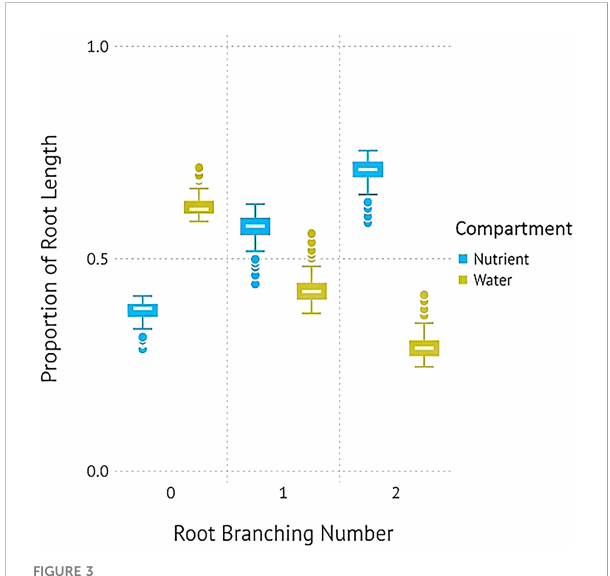
FIGURE 3 Proportions of root length for P. virgatum simulated with the 3D root structure CropRootBox.jl model parameterized for the resource-partitioned treatment in an attempt to replicate Figure 1A.